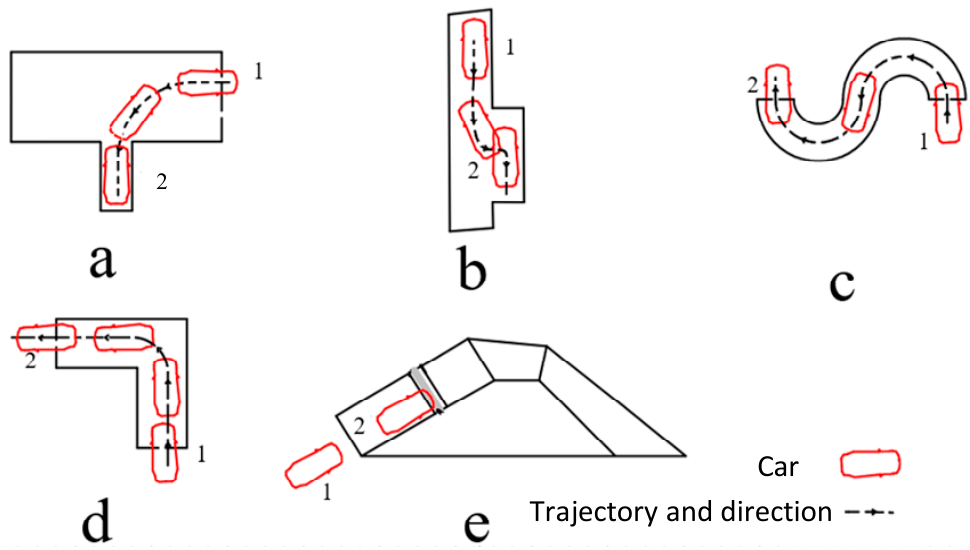
Figure 1. The five subjects of motor vehicle driver training course and driving license test in China: ( a ) Reverse parking, vehicles reverse from point 1 to point 2 in a T-shape polygon; and ( b ) parallel parking, vehicles reverse from point 1 to point 2 parallel; and ( c ) tortuous route, vehicles move from point 1 to point 2 following the “S” curve; and ( d ) quarter turn, vehicles move from point 1 to point 2 following a quarter turning and ( e ) ramp parking, vehicles move from point 1, parking in a set on the position on the road.